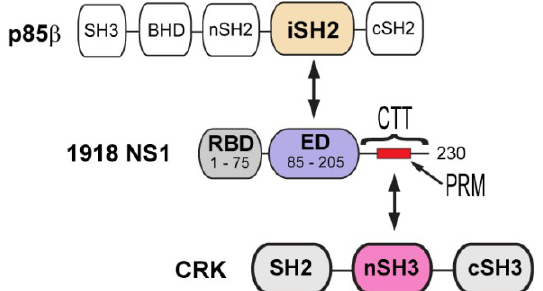
Figure 1. Domain organization of 1918 non-structural protein 1 (NS1), p85b, and CT-10 regulator of kinase (CRK). Arrows indicate the interacting domains between proteins.